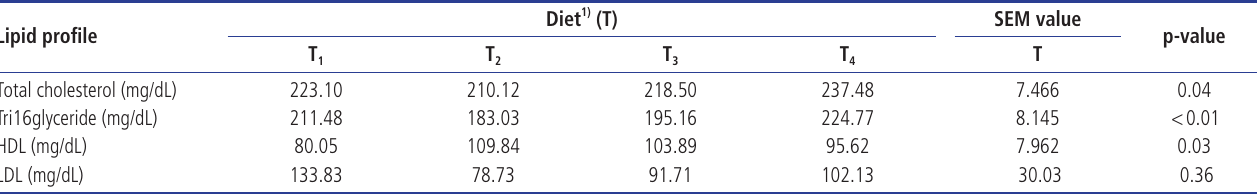
Table 5. Effect of Azolla or combination of multivitamin and acidifier on lipid profiles of blood of broiler chickens at 35 days of age Lipid